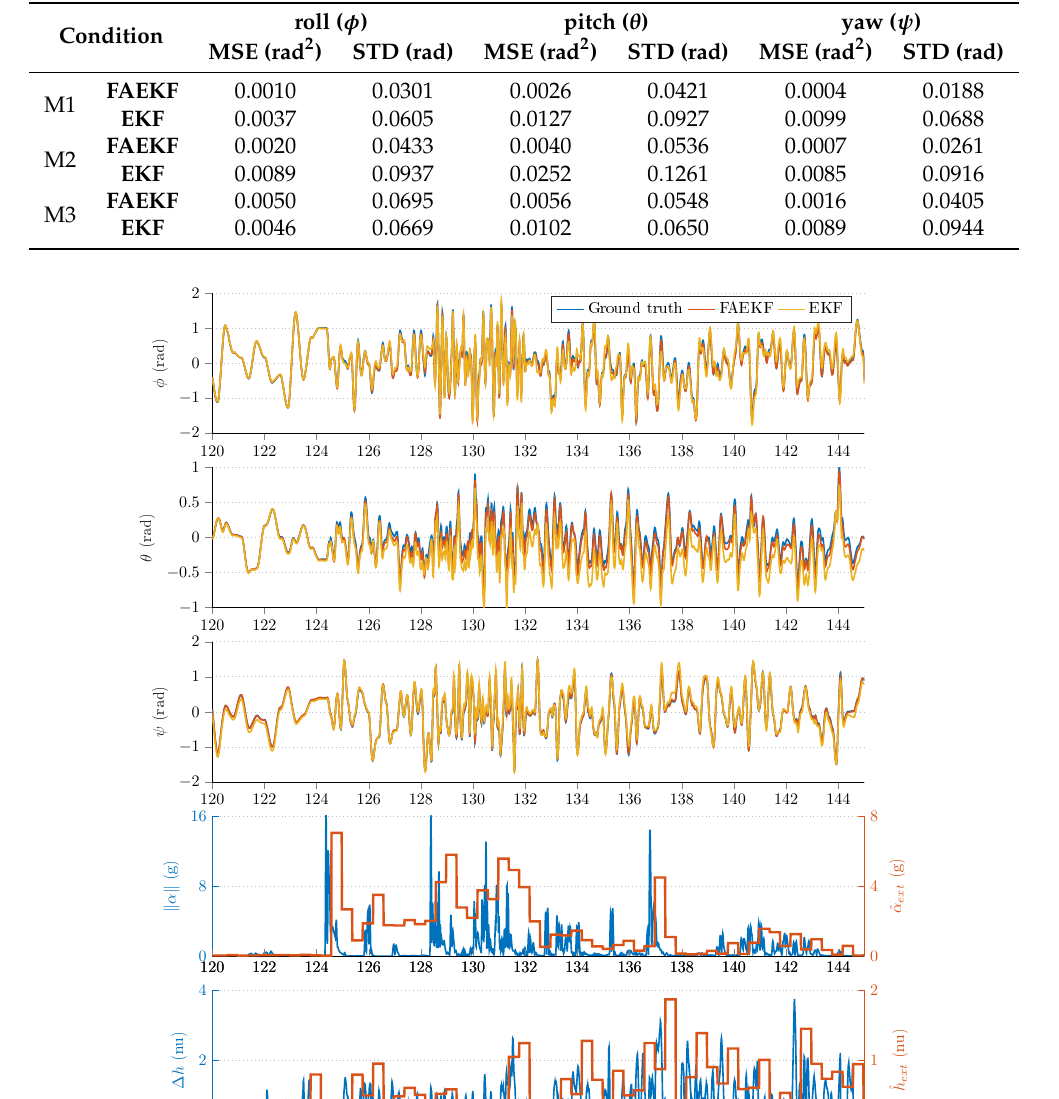
Table 2. Mean squared error (MSE) and standard deviation (STD) results of the investigated filters.